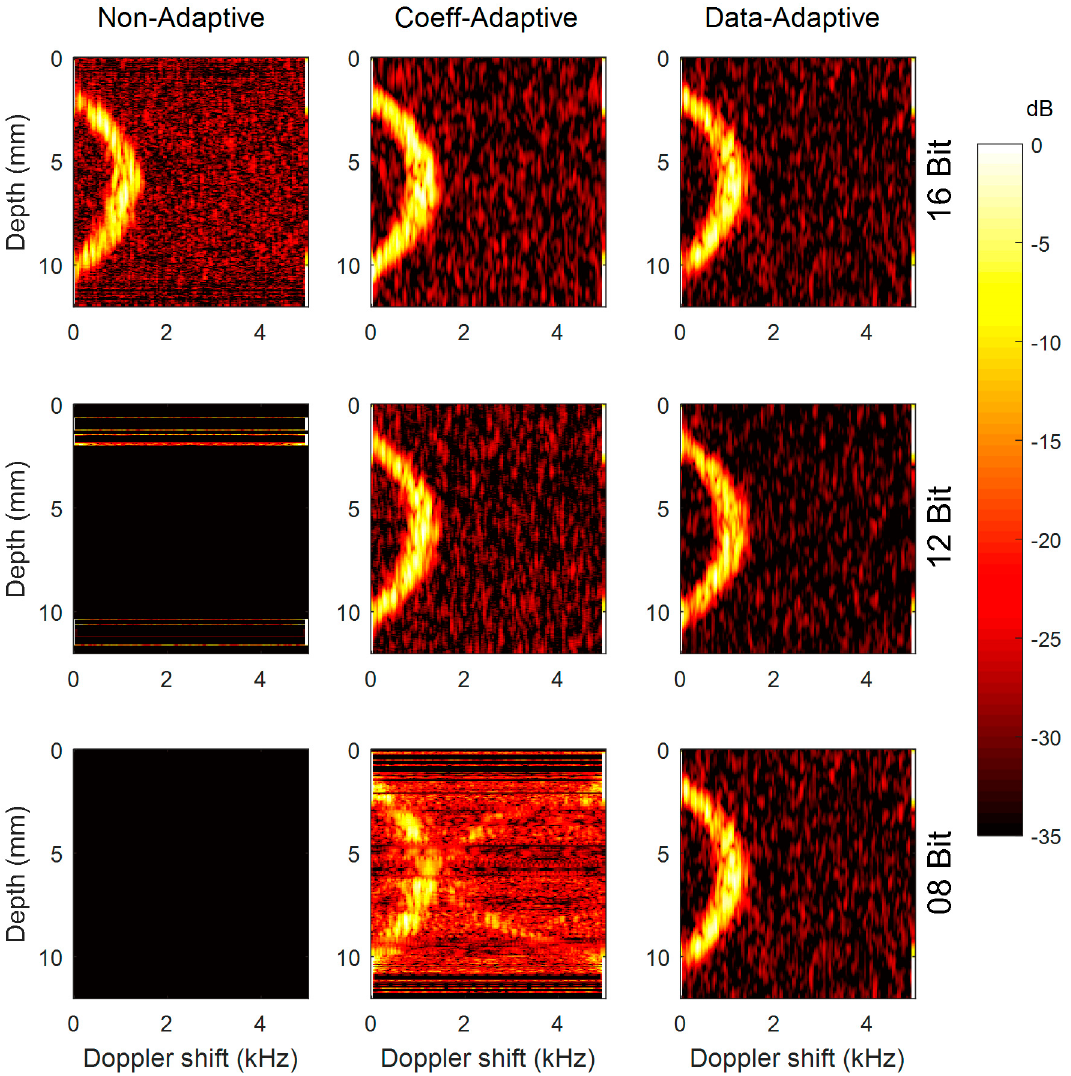
Figure 10. Power spectral matrices calculated by the system, including the proposed demodulator. Horizontal and vertical axes report Doppler shift and depth, respectively. Matrices processed with non-, coeff-, data- adaptive strategies are reported in columns; input signal equivalent to 16, 12, 08 bits are reported in rows.